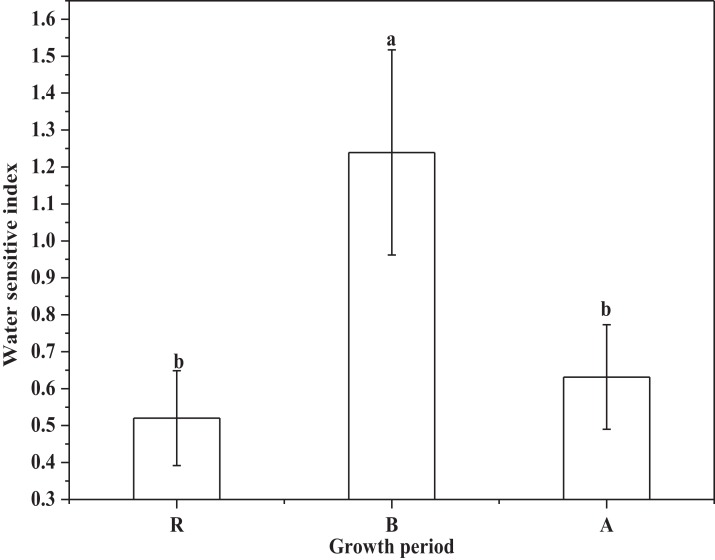
The water sensitive index of alfalfa (R, regreen period; B, branch period; A, flower period).The water sensitive index of alfalfa in regreen, branch, and flower stage. Lowercase letters indicate the results of ANOVA at α = 0.05.